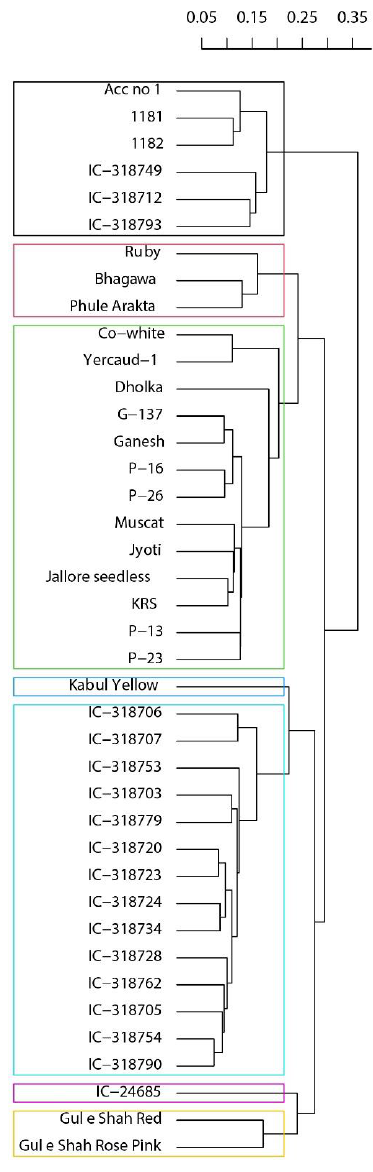
Figure 2. Hierarchical classification of the forty pomegranate accessions using morphological and biochemical data (Gower’s distance; UPGMA algorithm). Rectangles were drawn for k = 7.